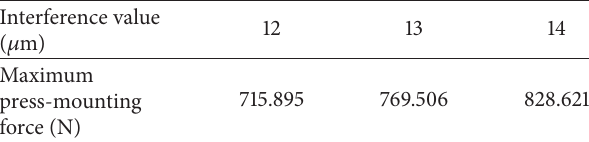
Table 4: Maximum press-mounting force obtained from FEA.